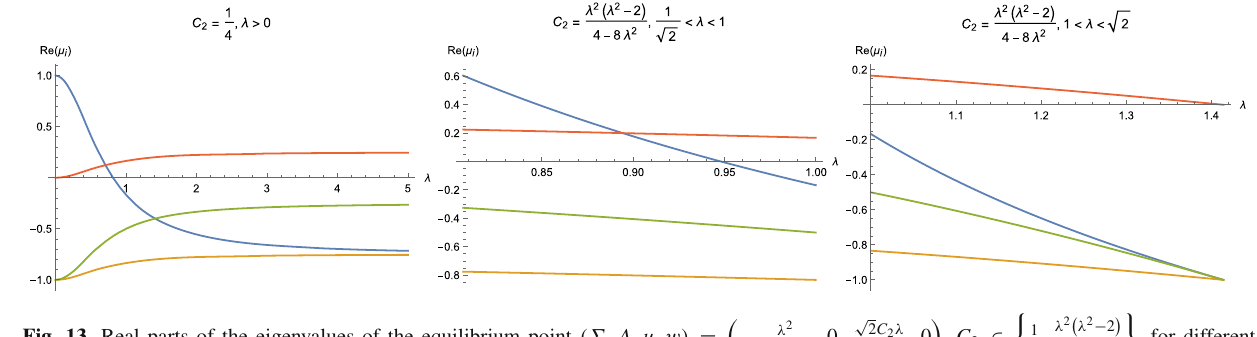
Fig. 13 Real parts of the eigenvalues of the equilibrium point (Σ, A , u ,w)